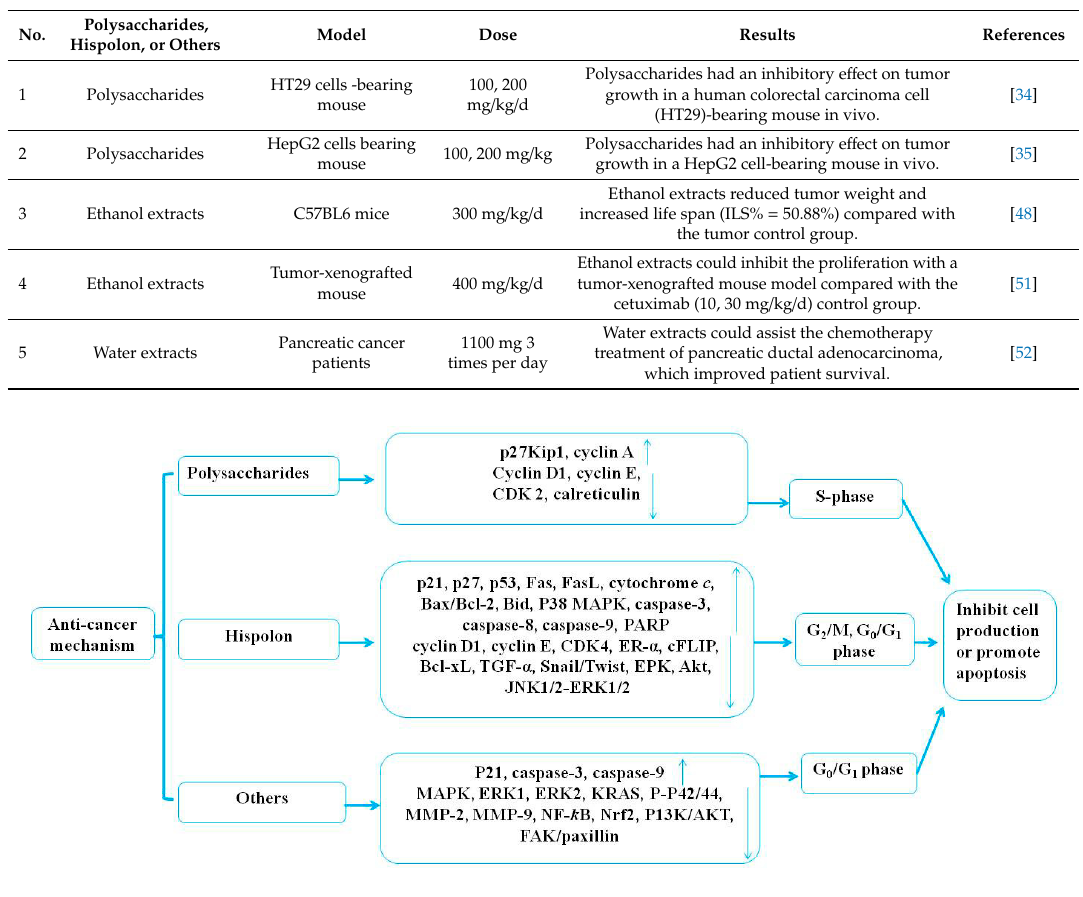
Figure 4. The potential anticancer mechanisms of P. linteus .